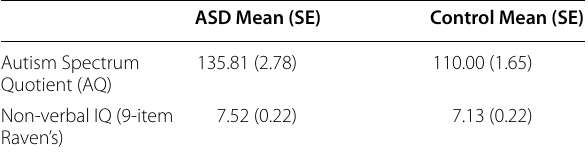
Table 1 Summary of AQ, EQ and 9-item Raven’s scores in control and participants with